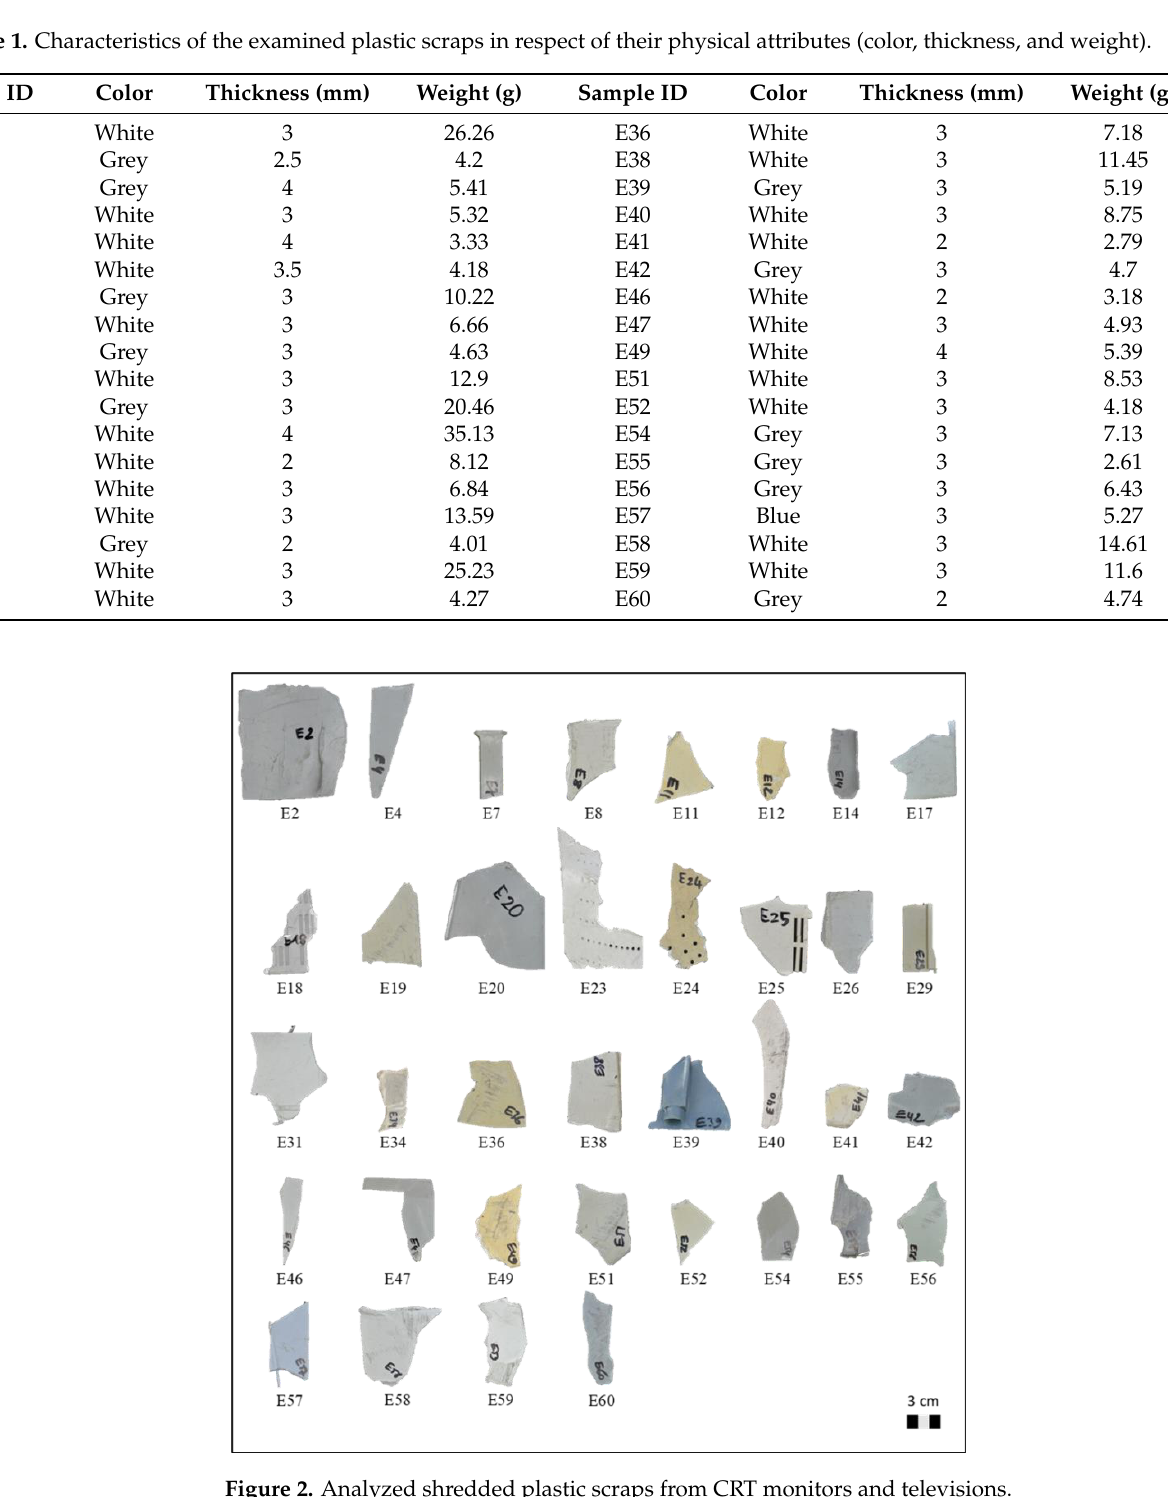
Figure 2. Analyzed shredded plastic scraps from CRT monitors and televisions. Table 1. Characteristics of the examined plastic scraps in respect of their physical attributes (color, thickness, and weight).